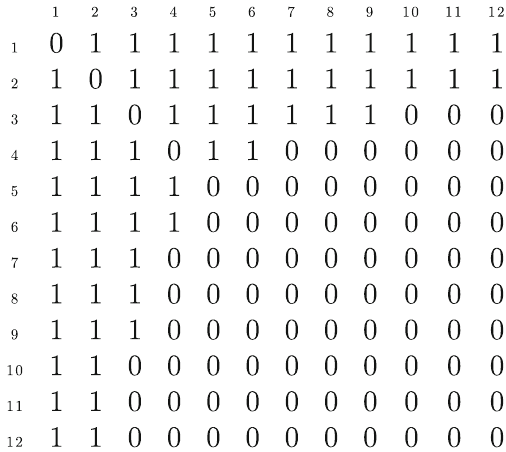
Fig. 1 A connected non-weighted